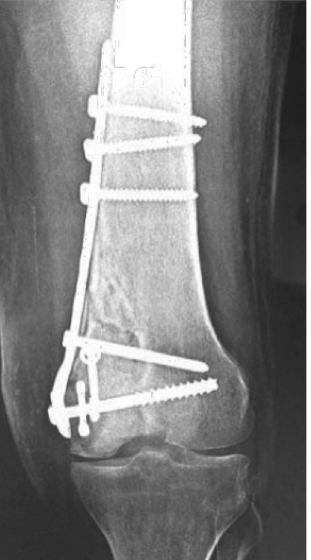
(a) Diagrammatic representation of 2 L plates with bone graft. Fig. 2: (b) Radiograph depicting union after nine months post-